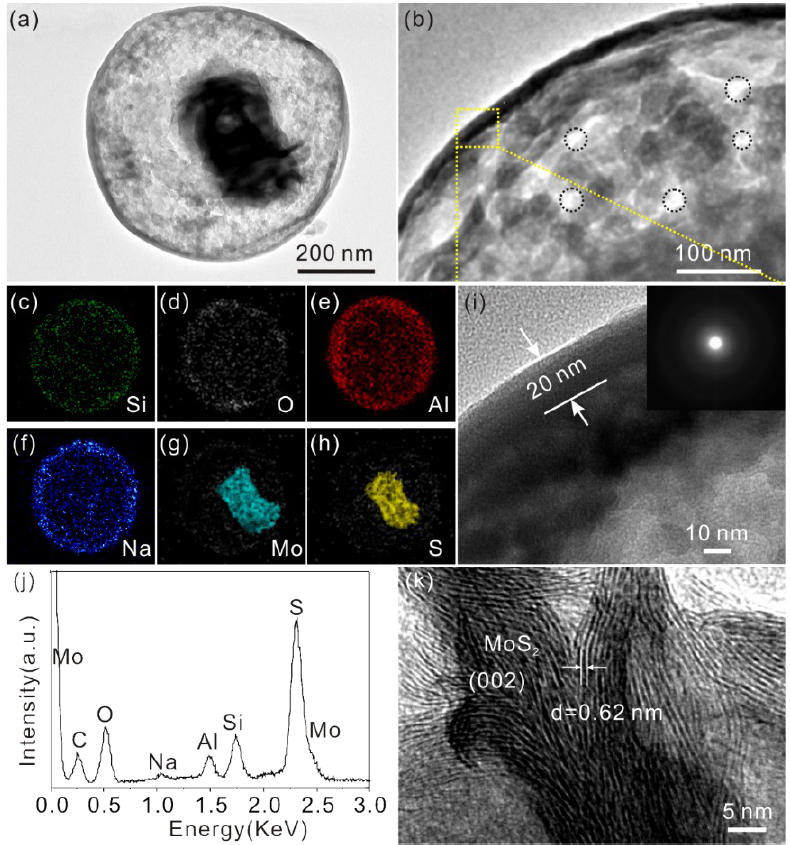
Figure 4. The images of the MoS 2 @void@Aluminosilica microspheres: ( a , b ) low-magnification TEM images; electron energy loss: ( c ) “Si”, ( d ) “O”, ( e ) “Al”, ( f ) “Na”, ( g ) “Mo” and ( h ) “S”; ( i ) HRTEM image and the corresponding SAED pattern (inset in ( i )); ( j ) EDS spectrum; ( k ) HRTEM image.